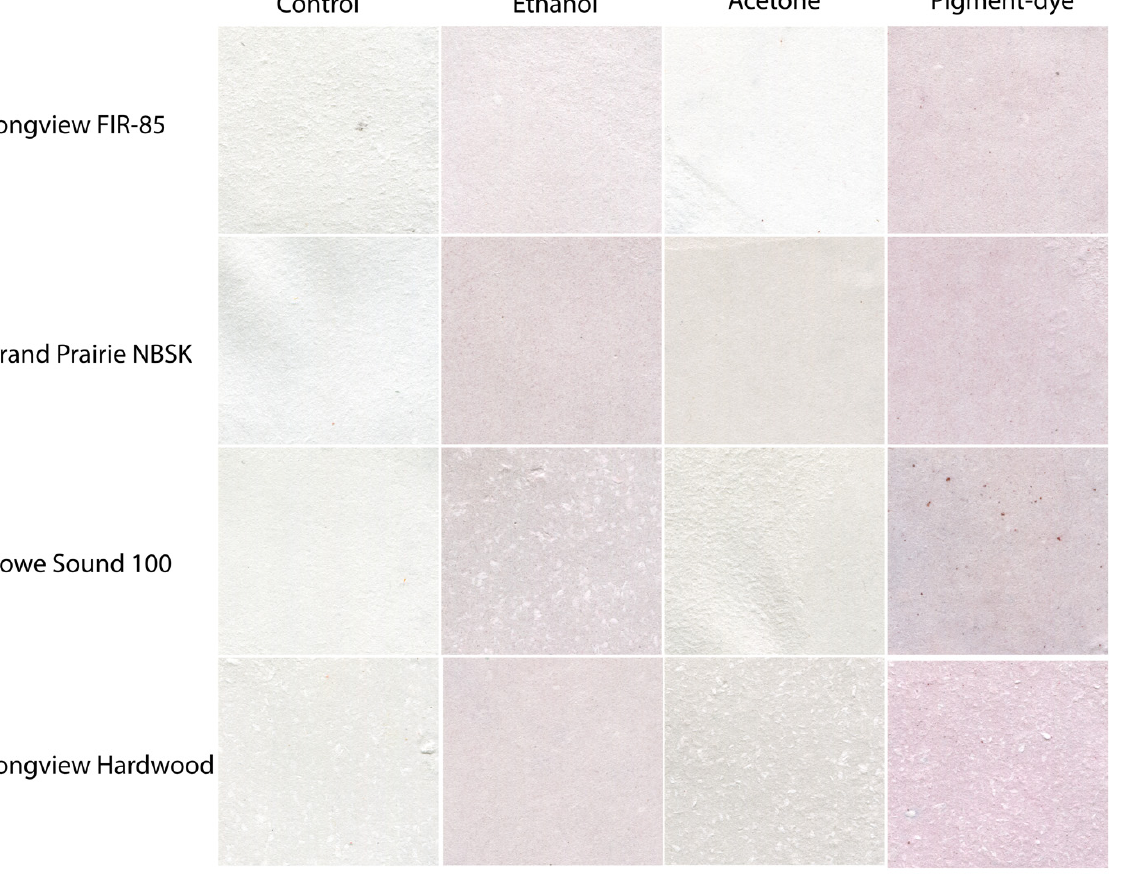
Figure 1. Scans of the final paper samples produced from the treated pulps by treatment type (ver- tical) and pulp type (horizontal). and pulp type